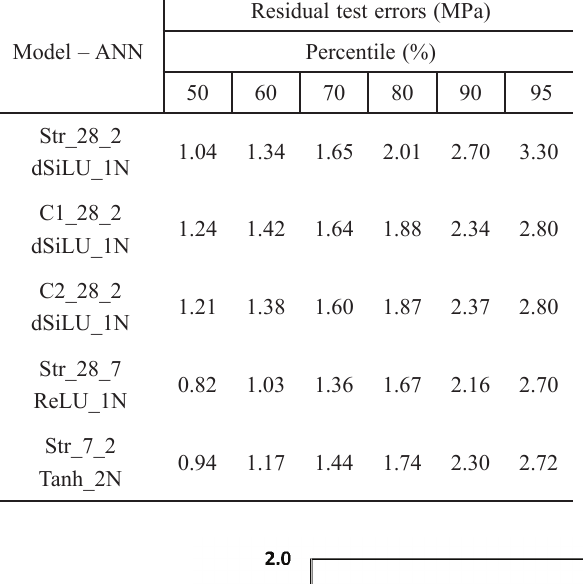
Table 7 – Cumulative distributions of the residual test errors